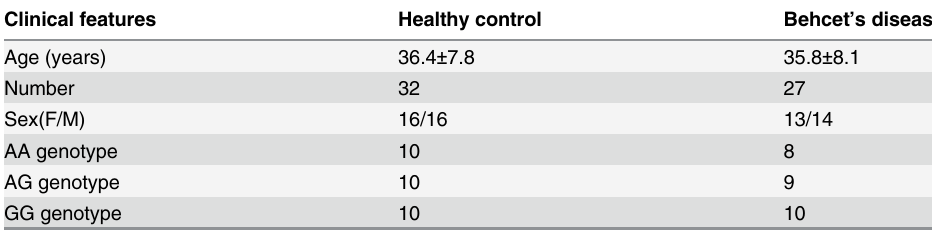
Table 1. Clinical characteristic of study